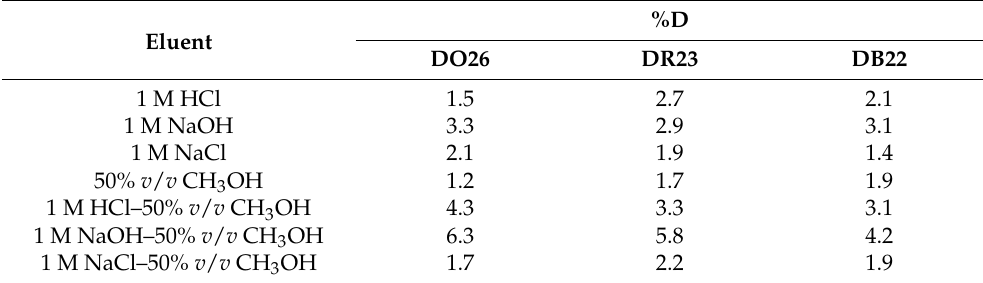
Table 5. Dyes desorption